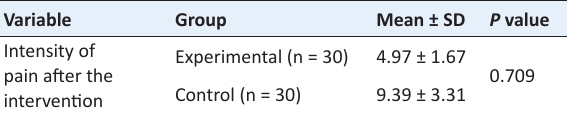
Table 2. Comparison of the mean intensity of leg muscle cramp pains after the intervention in the experimental and control